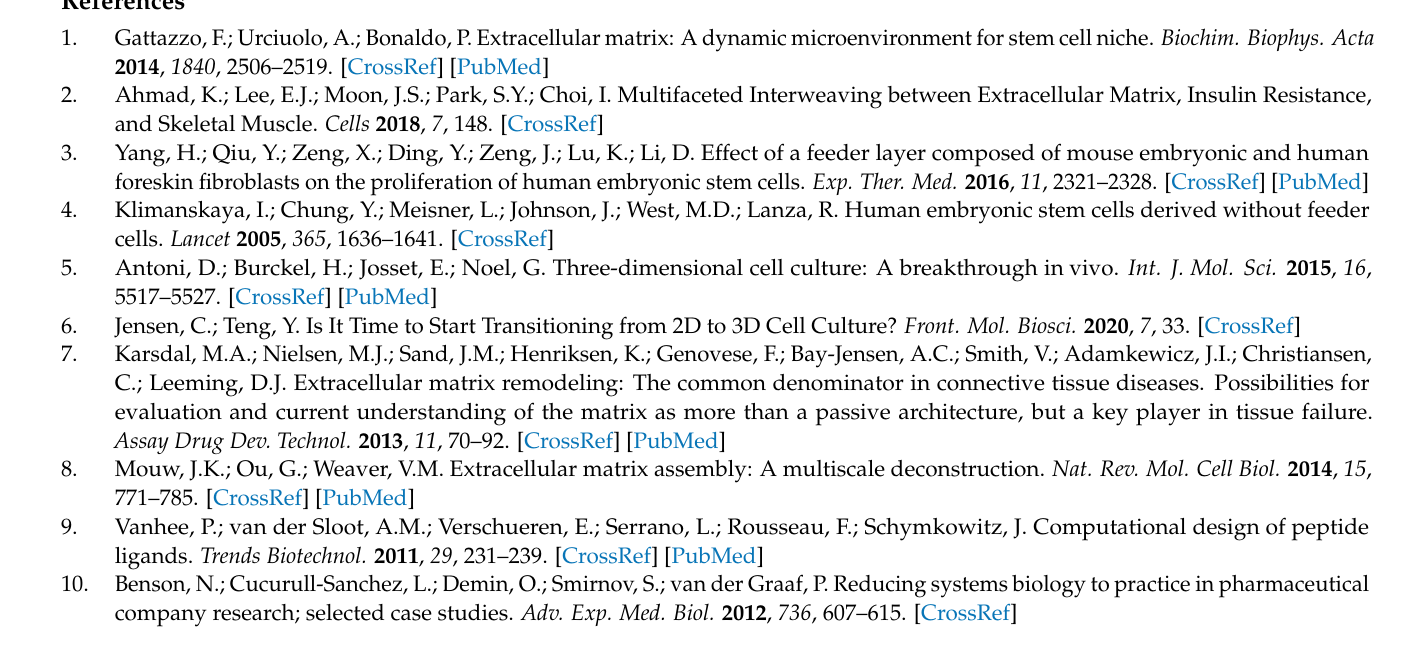
Supplementary Table S2. Cell culture and proliferation condition with FNINs; Supplementary Figure S1. Amino acids interactions between FNIN2 or FNIN3 and integrins ( α 5 β 1, α v β 3, and α IIb β 3); Supplementary Figure S2. Detection of FNIN2- NH2 binding in cells. Cells were incubated in cultured media supplemented with rhodamine for 30 min, washed with PBS, and observed under a fluores- cence microscope; Supplementary Figure S3. Improved coating efficacy of the FNIN peptide on a plate using a polymerization coating method with dopamine and tannic acid. (a) The characteristic of dopamine and tannic acid. (b) Cell proliferation and coating efficacy of FITC-FNIN- NH2 after pD and pTA pre-coating. Fluorescent intensity (FI) was measured with Spectral AmiX imaging analyzer (Spectral Instruments Imaging Inc., Tucson, AZ, USA) and represents FI = measured FI − FI (0). (c) The fluorescent intensity of FITC-FNIN- NH2 (2 µ M) coating after pD and pTA coating on a black plate (non-treated plate, not for cell culture) was measured using SpectraMax Gemini EM (Molecular Devices, USA). Blank represents the same concentration of FITC-FNIN- NH2 without polymerization of each buffer; Supplementary Figure S4. Whole